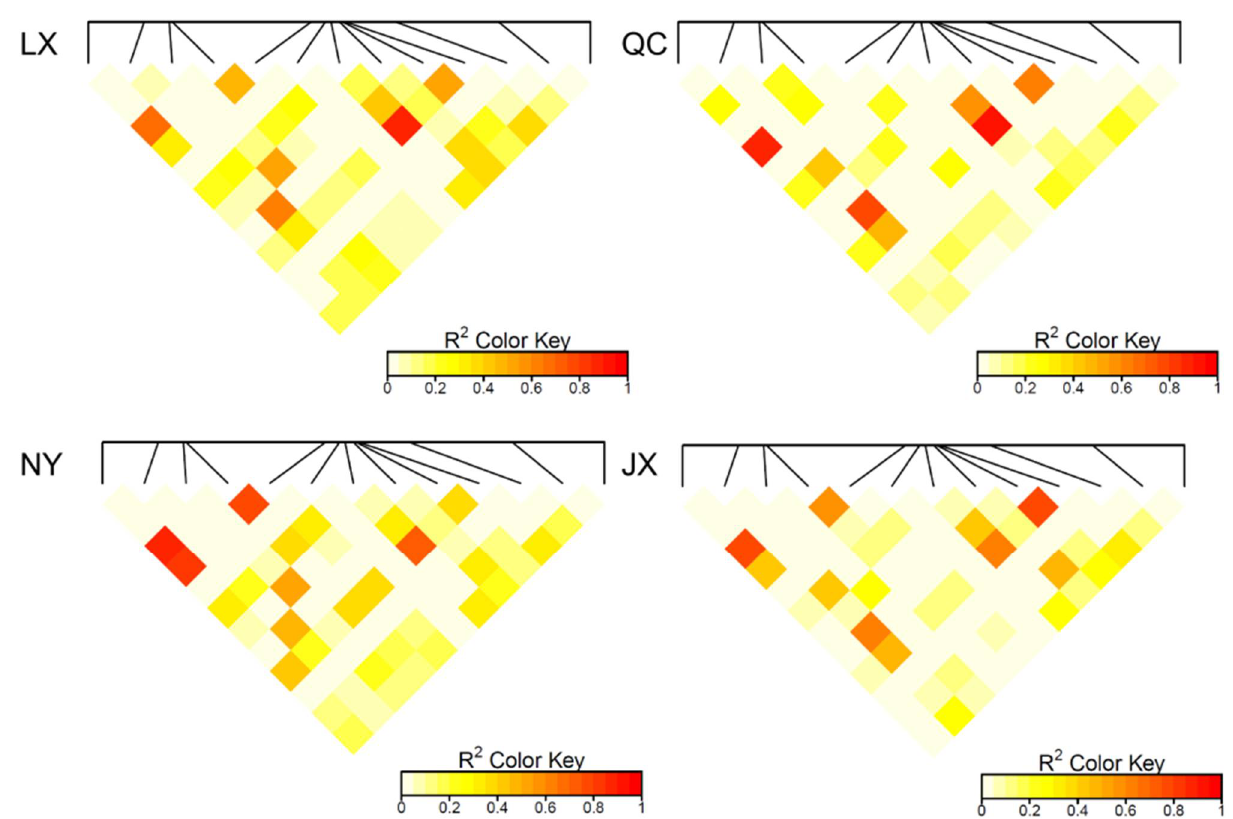
Figure 3. Linkage disequilibrium analysis ( R 2 ) of 13 variants in four cattle breeds. QC: Qinchuan cattle; NY: Nanyang cattle; JX: Jiaxian red cattle; LX: Luxi cattle. Table 3. Genotypes, alleles, He, Ne, and PIC for variations of the 14th intron, 15th exon, and downstream region in cattle PSAP. Table 5. Relationship between variations of PSAP and morphological